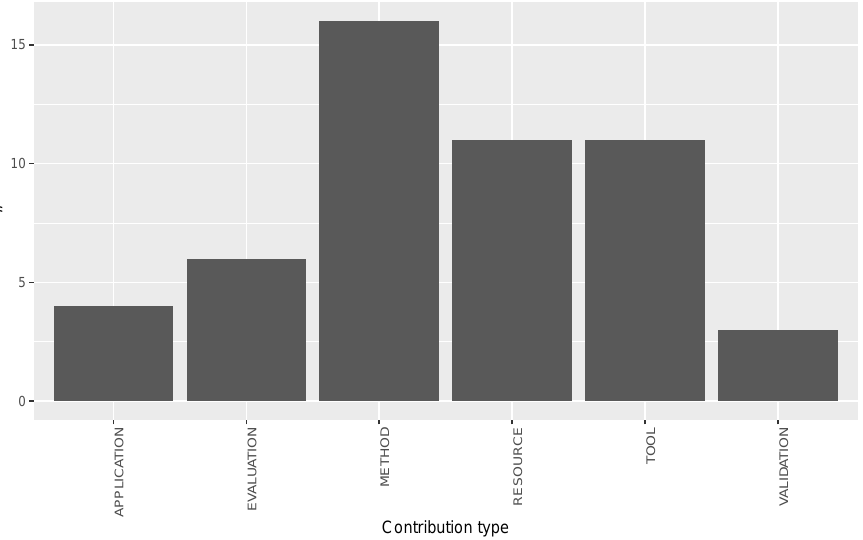
Figure 7. Type of contributions. (Authors’